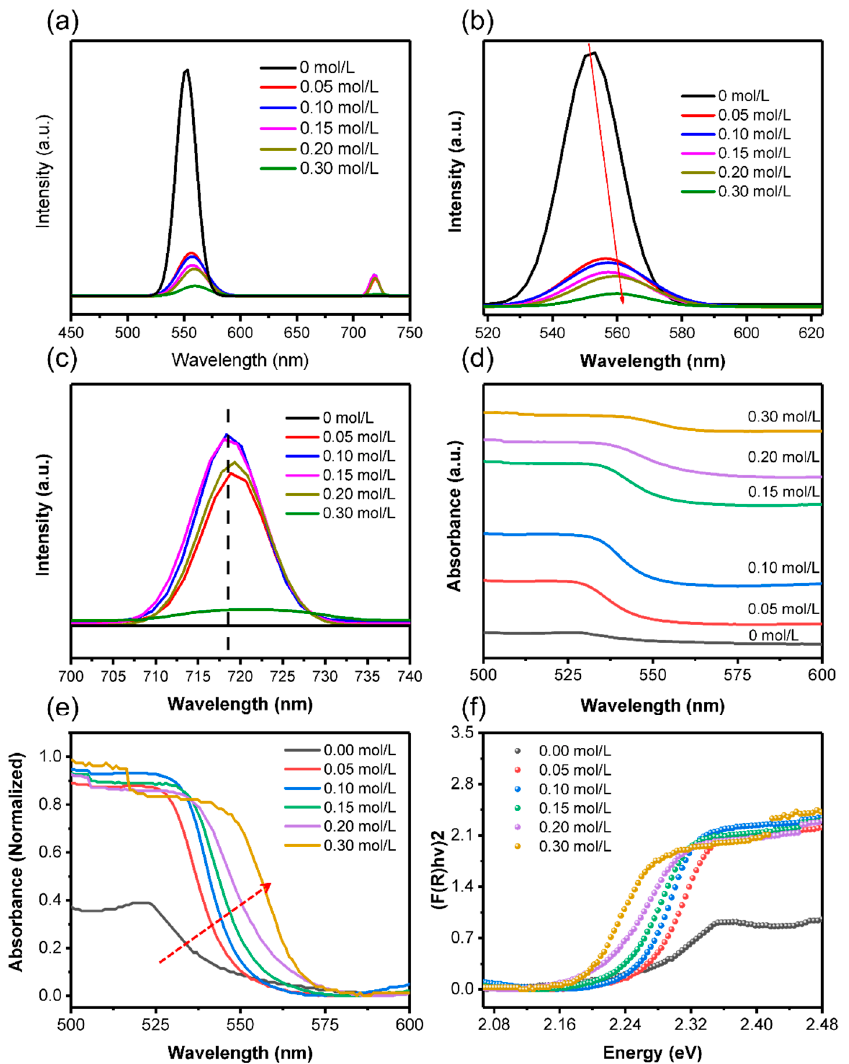
Figure 4. ( a ) PL spectra of the perovskite films with various PEAI concentrations. PL spectra of the first emission peak ( b ) and the second emission peak ( c ) at different PEAI concentrations. Absorbance spectra ( d ) and normalized absorbance spectral ( e ) of the perovskite films with various PEAI concentrations ( f ) bandgap energy of the perovskite films.